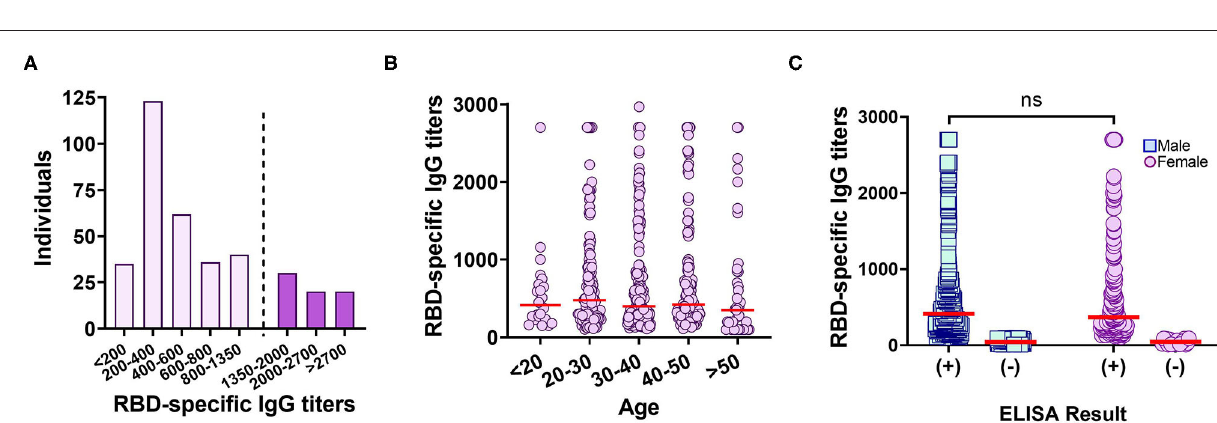
of Tucumán was consistent with previous seroprevalence reports